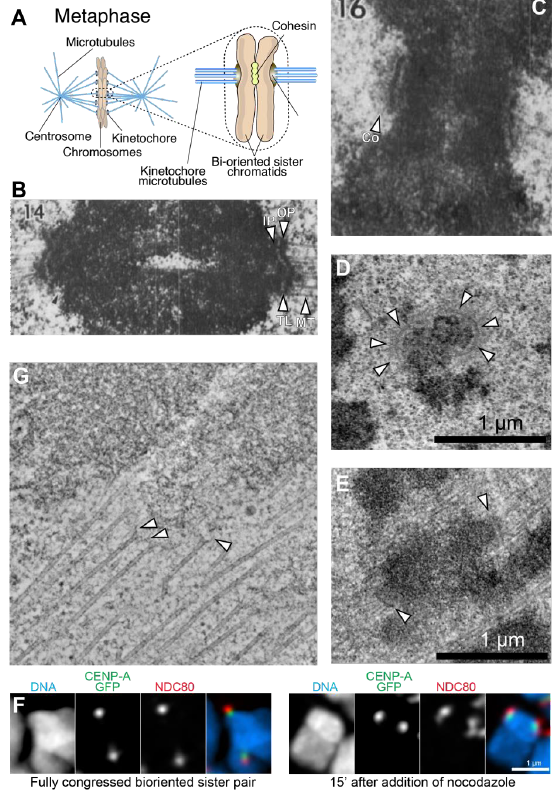
Figure 1. Kinetochore morphology in vertebrate cells ( A ) Schematic showing the attachment of chromosomes to spindle microtubules through kinetochores; ( B ) Early work on the kinetochore identified inner and outer plates, separated by a translucent layer. Microtubules terminate end-on on the kinetochore outer plate. Arrowheads indicate inner plate (IP), outer plate (OP), translucent layer (TL), and kinetochore microtubules (MT). Image reproduced with permission from reference [7]; ( C ) The corona (Co) is a fibrous structure that is more clearly visible on kinetochores prior to microtubule attachment. Image reproduced with permission from reference [7]; ( D , E ) Prior to microtubule attachment ( D ), vertebrate kinetochores adopt a crescent-like shape. The latter is not visible on fully congressed and bi-oriented kinetochores. Images courtesy of Alexey Khodjakov. See also reference [8]; ( F ) Left: at metaphase, the distributions of two proteins in the inner and outer kinetochores (NDC80 and CENP-A respectively), are similar; Right: After treatment with a microtubule-depolymerizing drug (nocodazole), proteins in the corona (not shown) and in the outer kinetochore undergo an expansion and form the crescent-like shape already shown in D . Image courtesy of Alexey Khodjakov. See